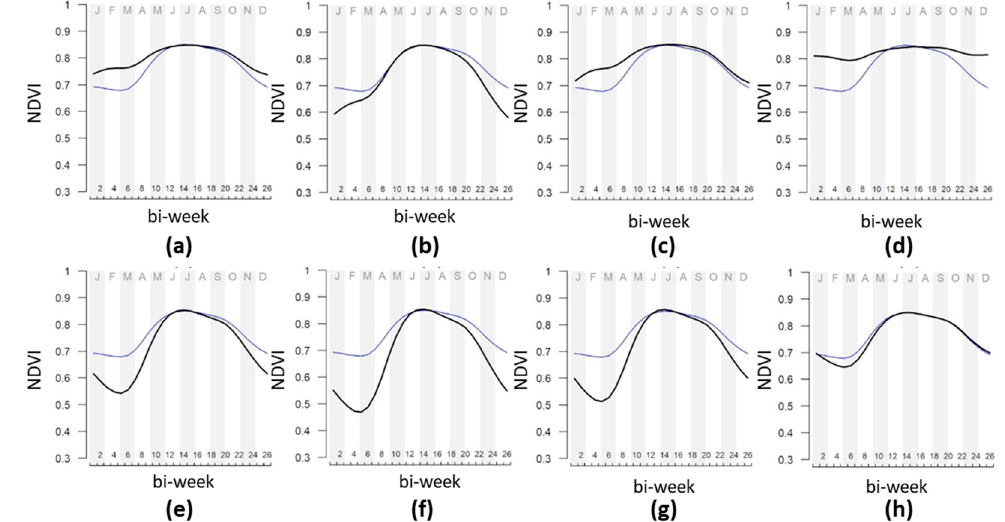
Figure 5. Mean NDVI time profile of plant communities (clusters) and study areas (black lines). Blue lines are the overall mean NDVI time profile of the 64 locations sampled by phytosociological relevés. Study areas: ( a ) Mount Conero and ( e ) Mount Valmontagnana. Plant communities: ( b ) Cluster 3, ( c ) Cluster 2, ( d ) Cluster 5, ( f ) Cluster 6, ( g ) Cluster 4, ( h ) Cluster 1.